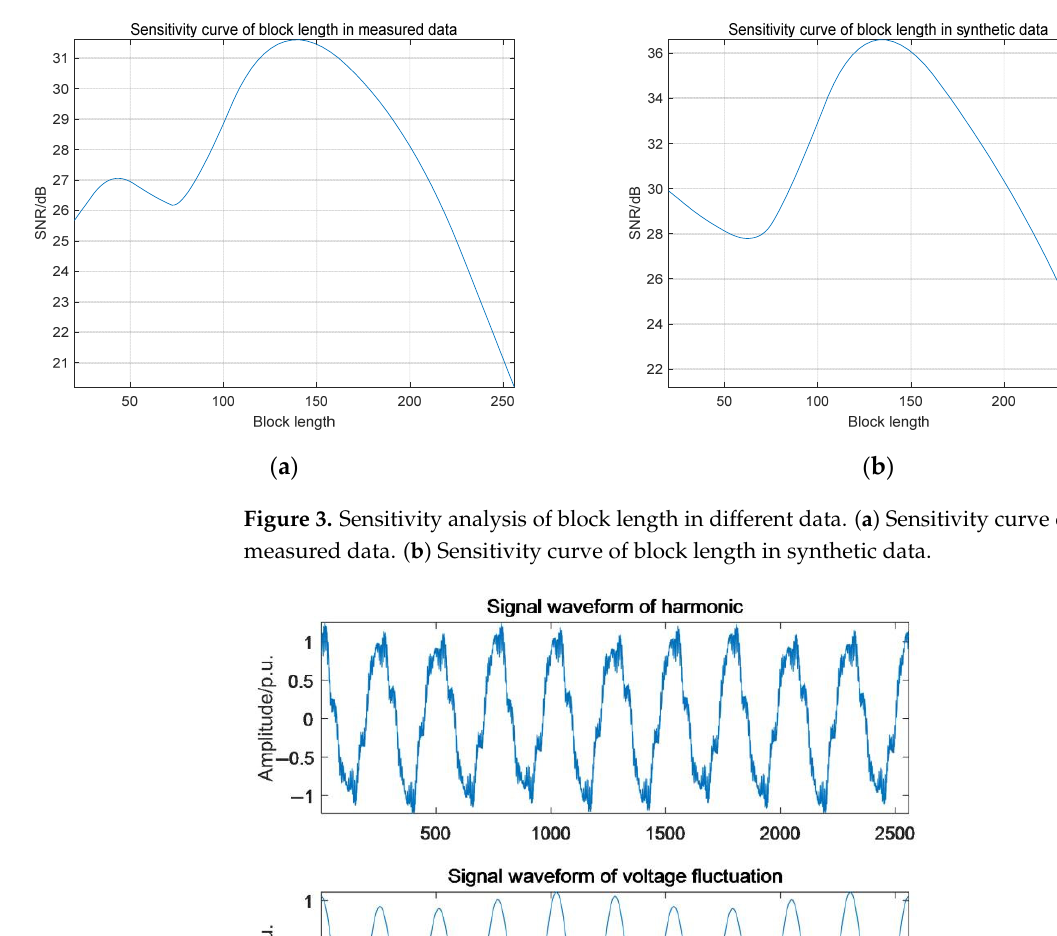
μ in different data. ( a ) Sensitivity curve of th